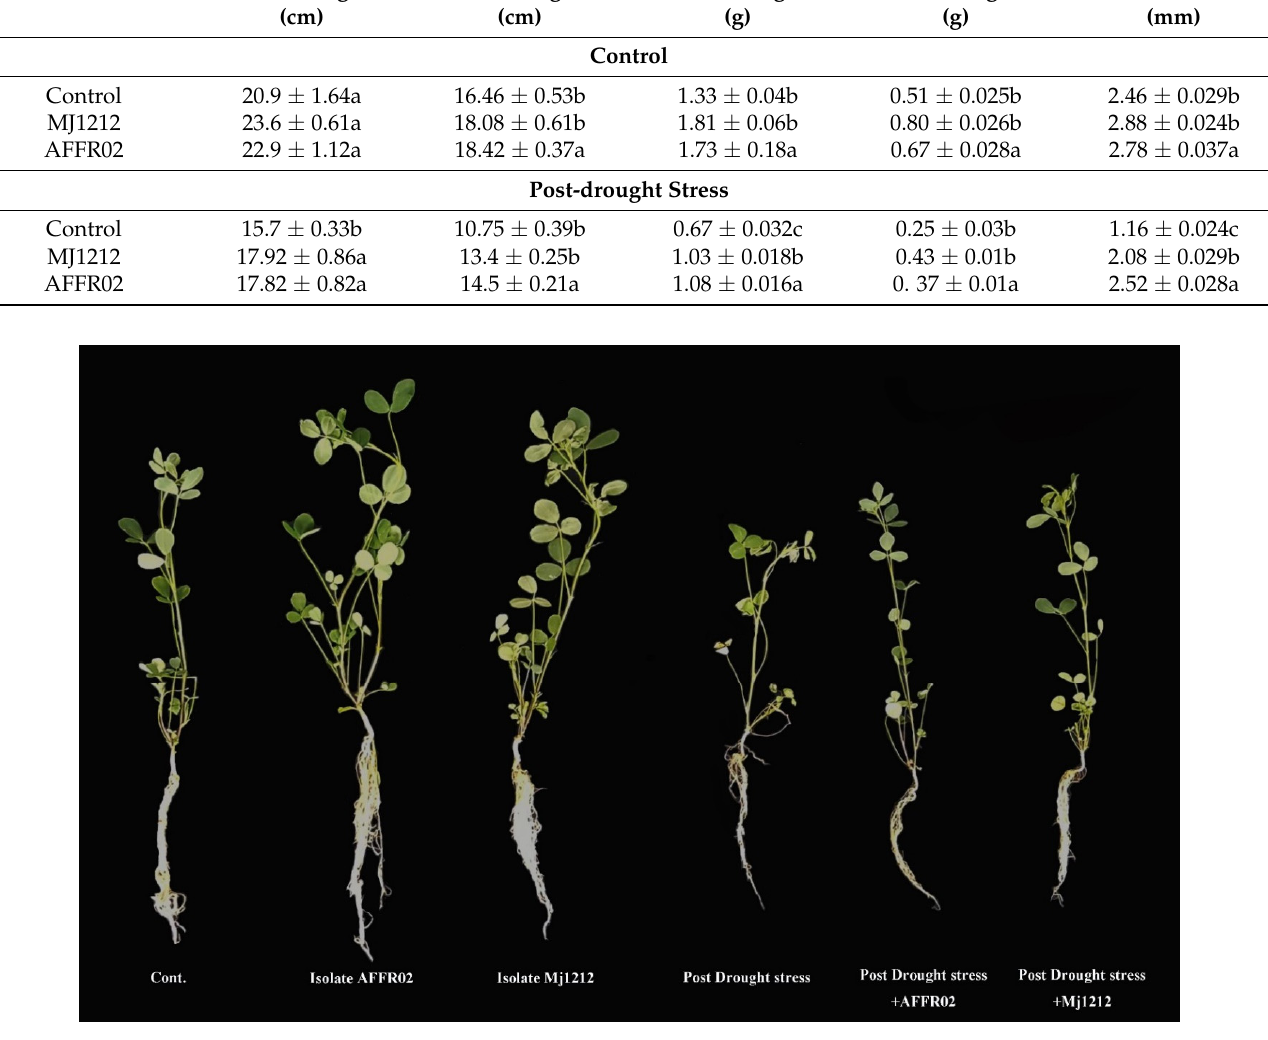
Figure 3. Effect of bacterial isolates AFFR02 and Mj1212 on the growth of alfalfa plants under normal and post-drought stress conditions. Table 1. Effect of isolate AFFR02 and MJ1212 on the growth attributes of alfalfa plants under normal and post-drought stress conditions. Each value in the table is the mean ± standard deviation of three replicates. Mean in columns followed by different letters describes significant difference by using Duncan’s multiple range test at p > 0.05.